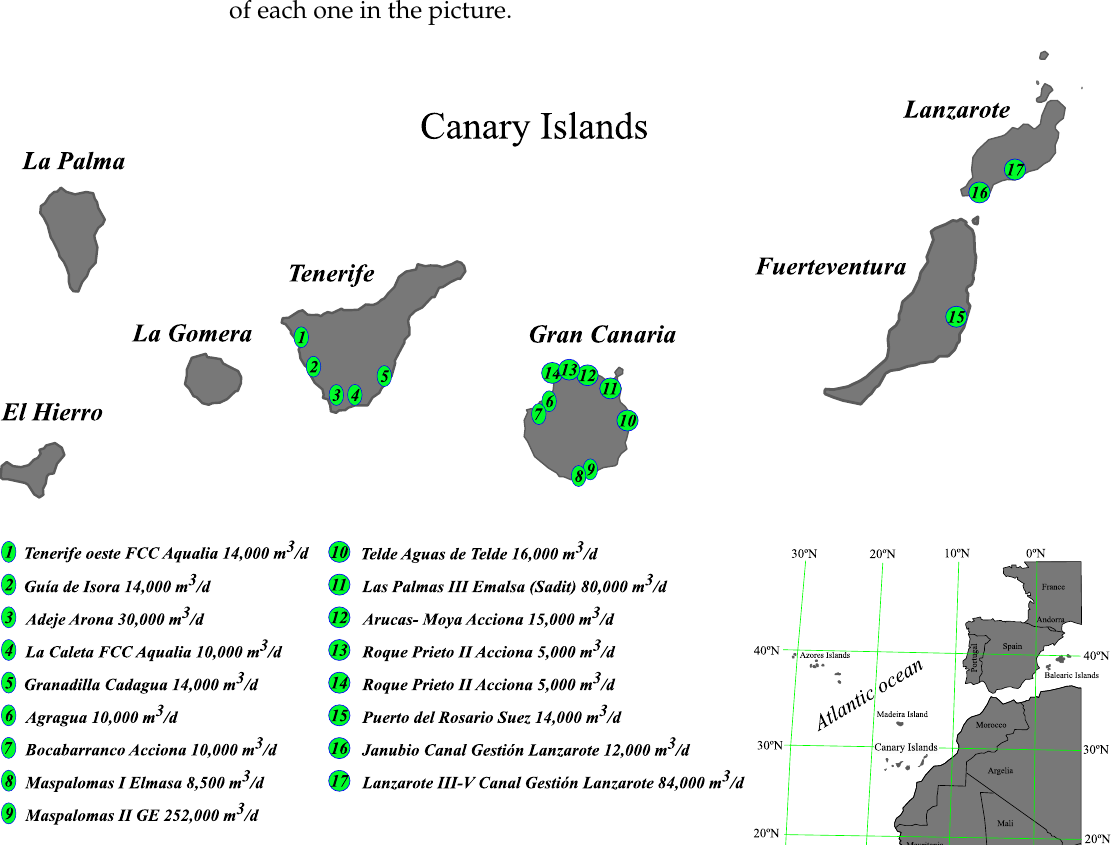
Table 8. Carbon footprint according to the technological structure of the generation parks that uses oil products in the Canary Islands, broken down by islands (2017) [15].